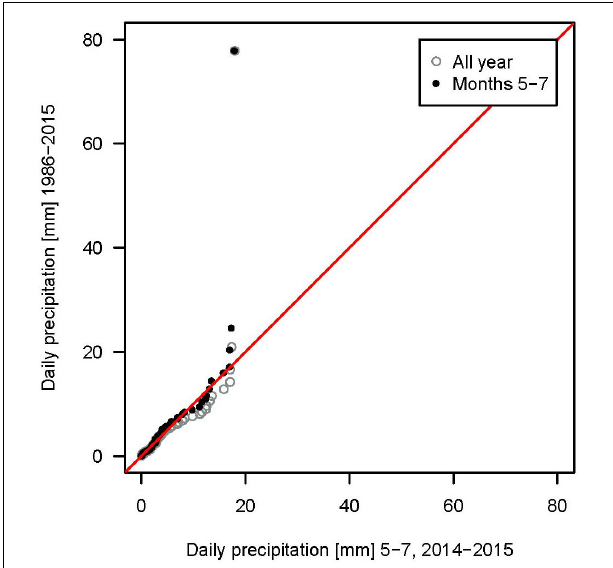
FIGURE 1 | Quantile-Quantile plot of daily precipitation sums of the 30-year climate measured at the German Weather Service (DWD) station in Mühlhausen in relation to the weather during the periods when stand precipitation measurement campaigns took place (May–July 2014 and 2015).